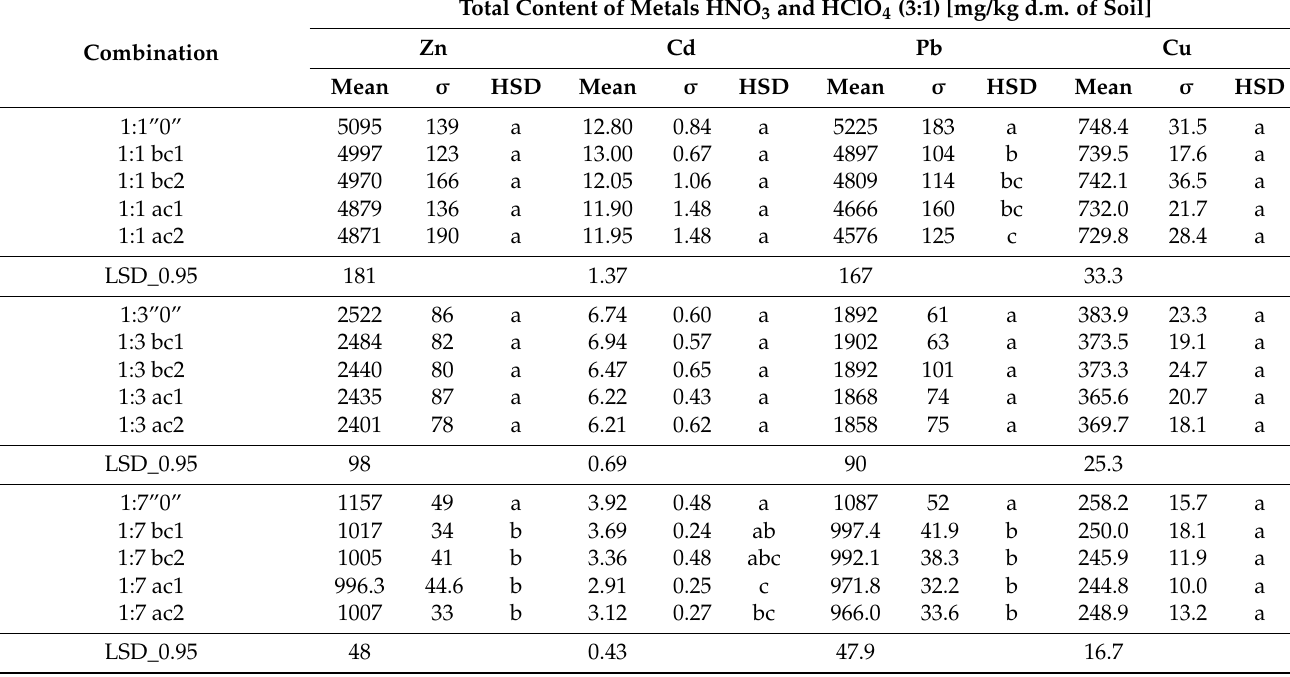
Table 3. Total metal concentration in soil depending on the dose of brown coal and activated carbon.